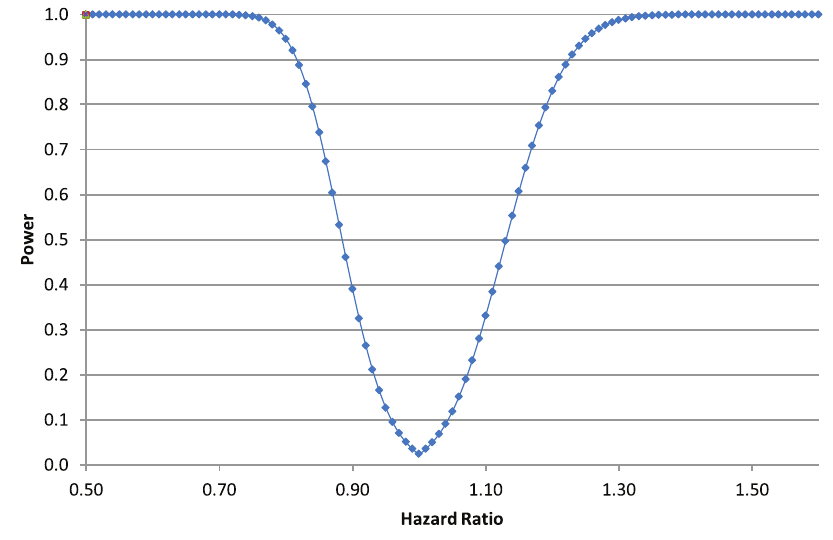
Figure 1. Expected statistical power as a function of the hazard ratio.